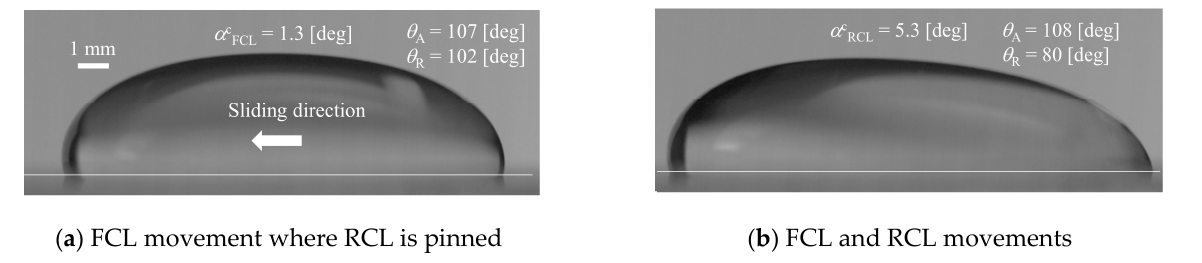
Figure 10. Images for onset of each contact line (CL) of the water droplet (550 μ L).